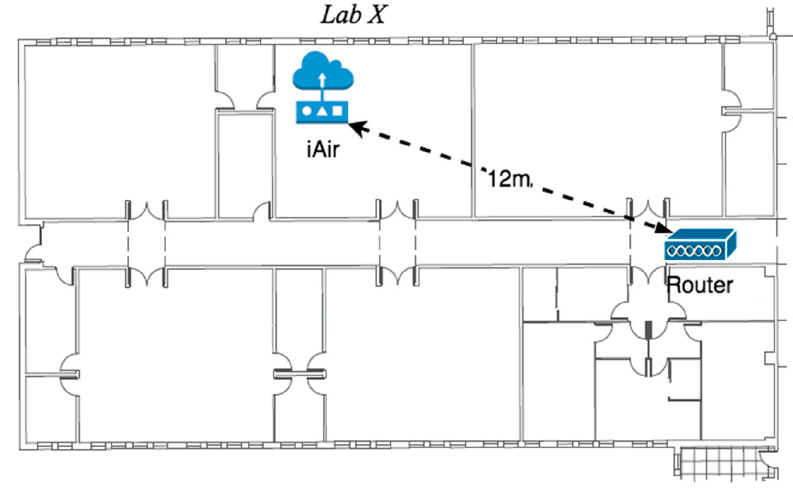
Figure 7. Installation schema.